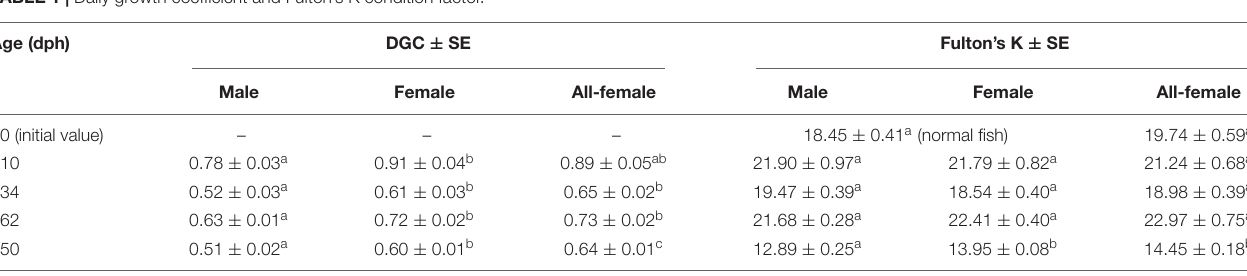
TABLE 1 | Daily growth coefficient and Fulton’s K condition